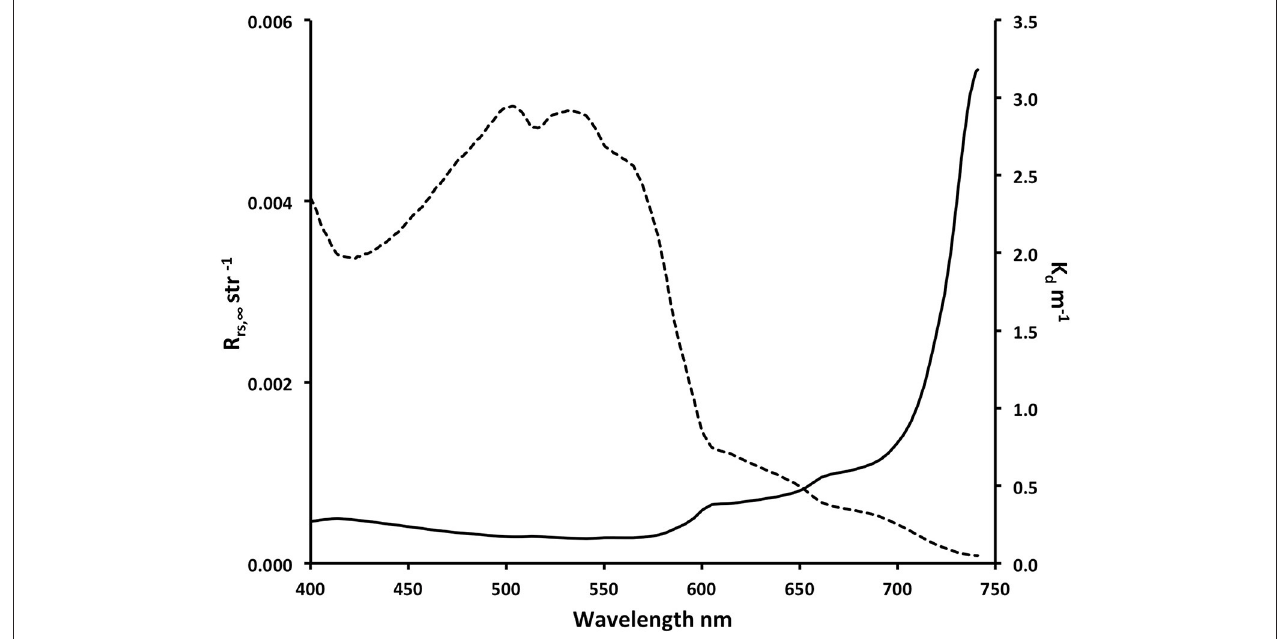
FIGURE 6 | Remote sensing reflectance R rs , ∞ str − 1 (dashed curve) and diffuse attenuation of downwelling irradiance K d , λ m − 1 (solid curve) computed from near-surface, in situ optical measurements collected over the coconut patch reef.